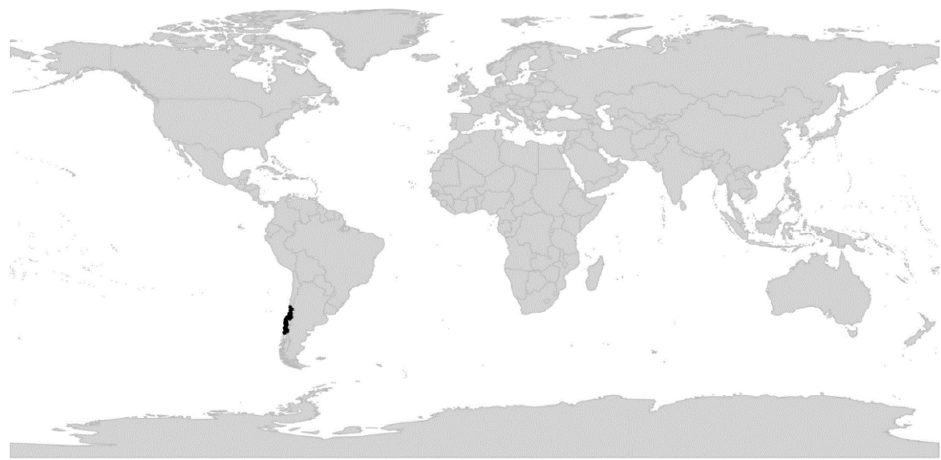
Figure 28. Global distribution of Viola sect. Rubellium .